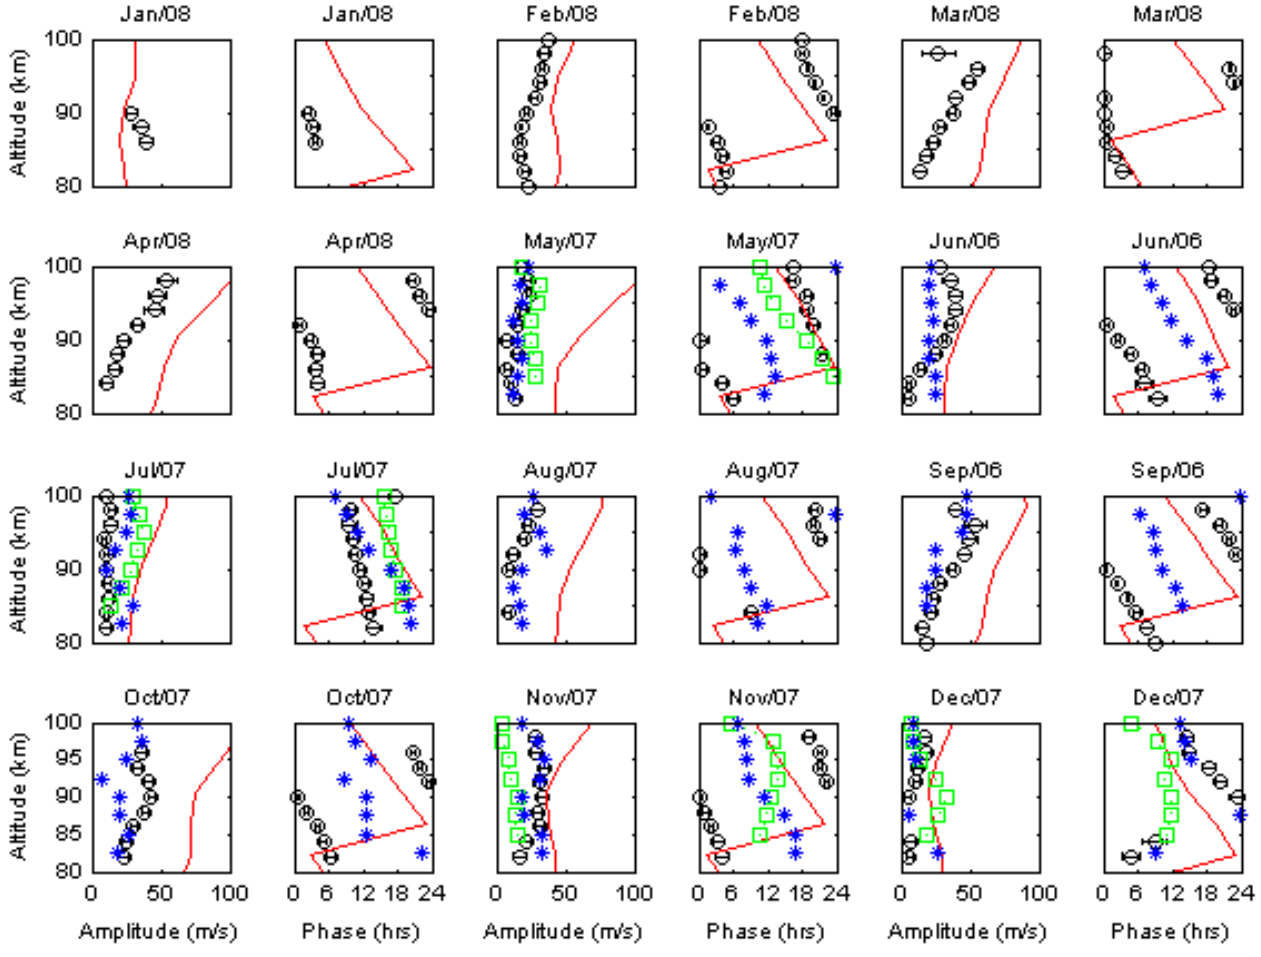
Fig. 4. Same as Fig. 2, but for zonal semidiurnal